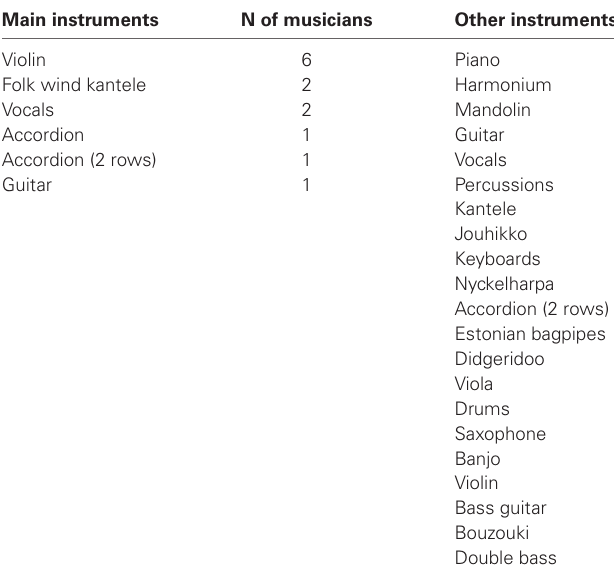
Table 1 | Instrumental background of the Folk